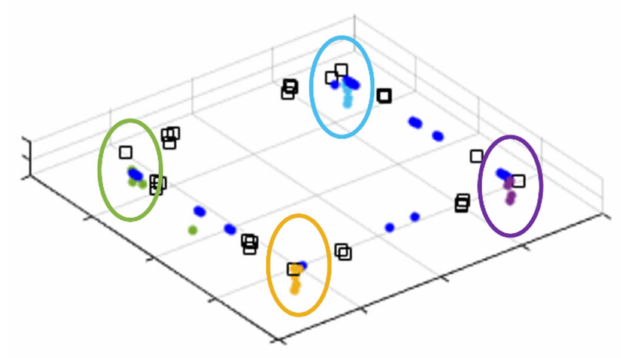
Figure 3. Accumulated corner extracted from scan points.